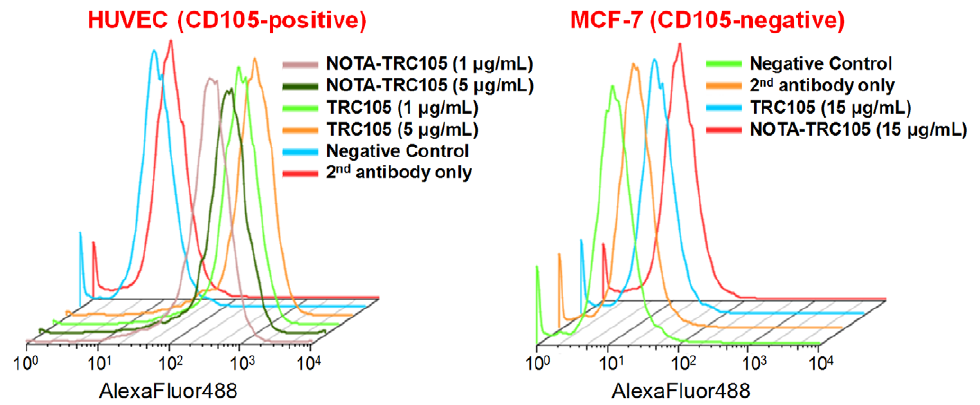
Figure 2. Flow cytometry analysis of TRC105 and NOTA-TRC105 in HUVECs (CD105-positive) and MCF-7 (CD105-negative) cells at different concentrations.